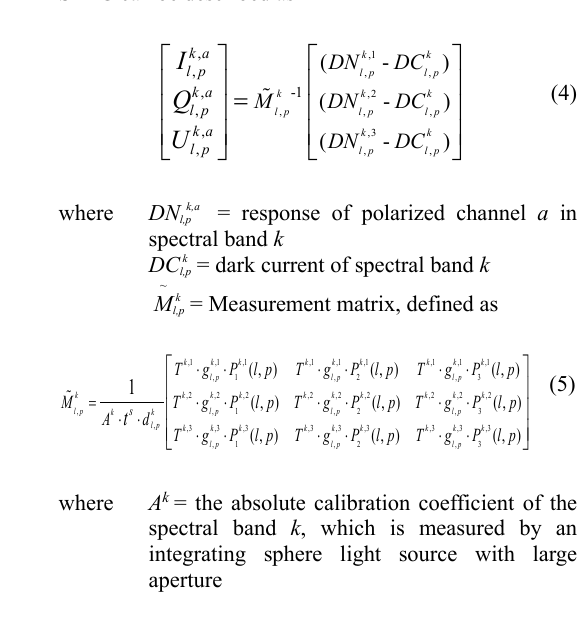
array with no polarizer in the optical structure I k,a = measured intensity of the pixel which l,p coordinates position is ( l , p ) polarization. where γ denotes maximum transmission. χ denotes the angle between the vibration direction of incident light and the direction of the maximum transmission of optical lenses. It can be seen from Eq. (3) that the ultra-wide- angle telecentric optical lenses obviously change the polarization state of the oblique incident light. The polarimetric calibration model for polarized channels of SDPC can be described